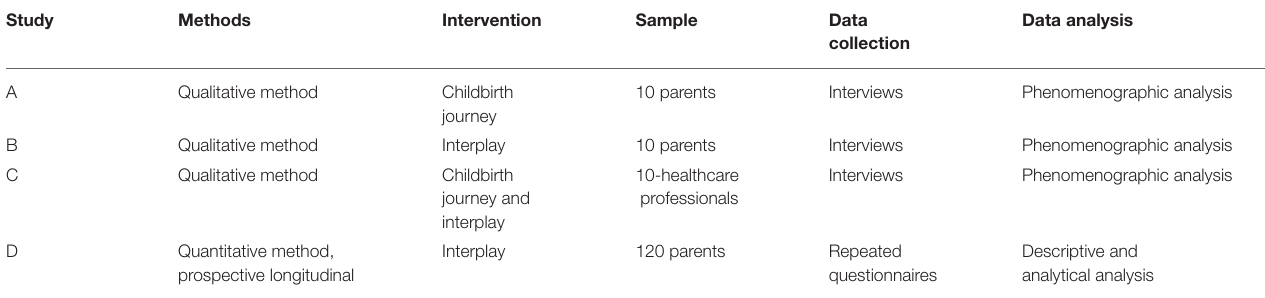
TABLE 1 | Overview of studies including methods, interventions, sample, data collection and data